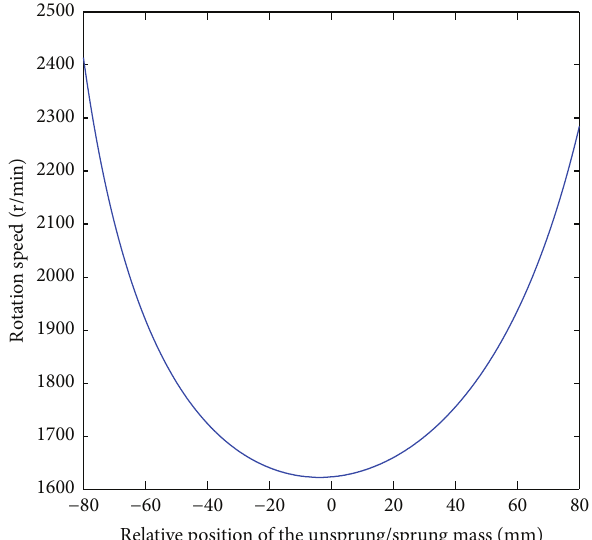
Figure 9: Rotation speeds of the motor shaft versus different relative position of the unsprung mass.